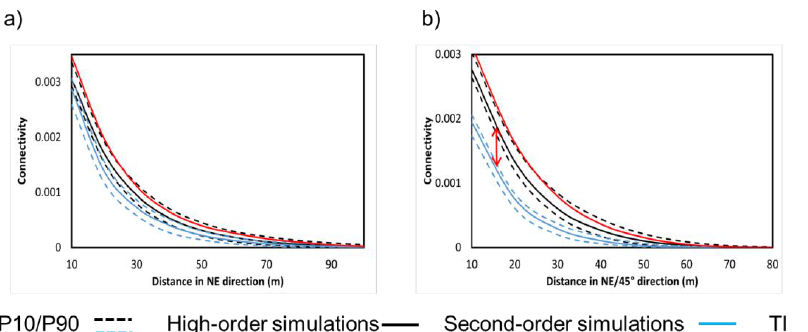
Figure 4. Connectivity of simulated realizations at ( a ) NE direction; ( b ) NE/45° direction. The arrow highlights the gap between the outcomes from the two methods.